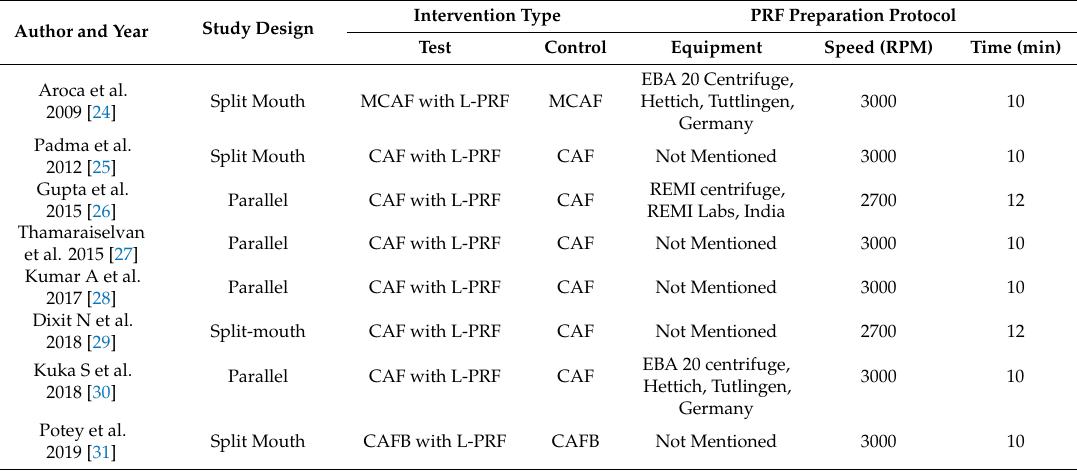
Table 2. Preparation protocol of leukocyte and platelet-rich fibrin (L-PRF) among included